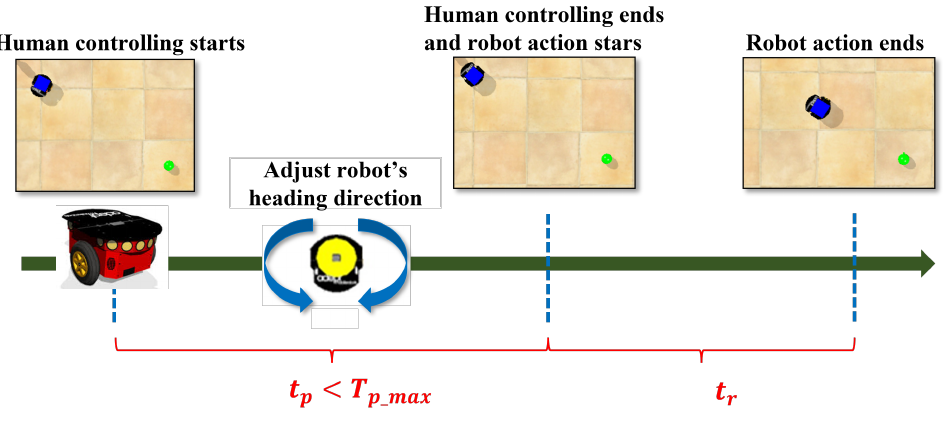
Figure 5. Robot and human interaction in each